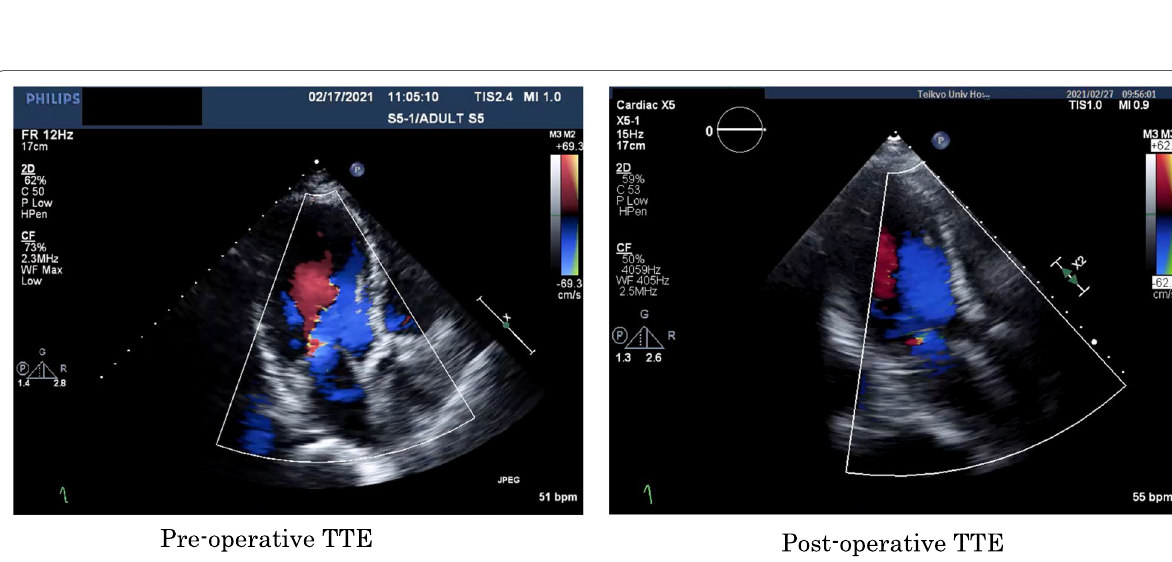
Fig. 4 Pre- and postoperative transthoracic echocardiography (TTE). Comparison of post-operative TTE and that of pre-operation.